Question: Does the plotted quantity increase or decrease?
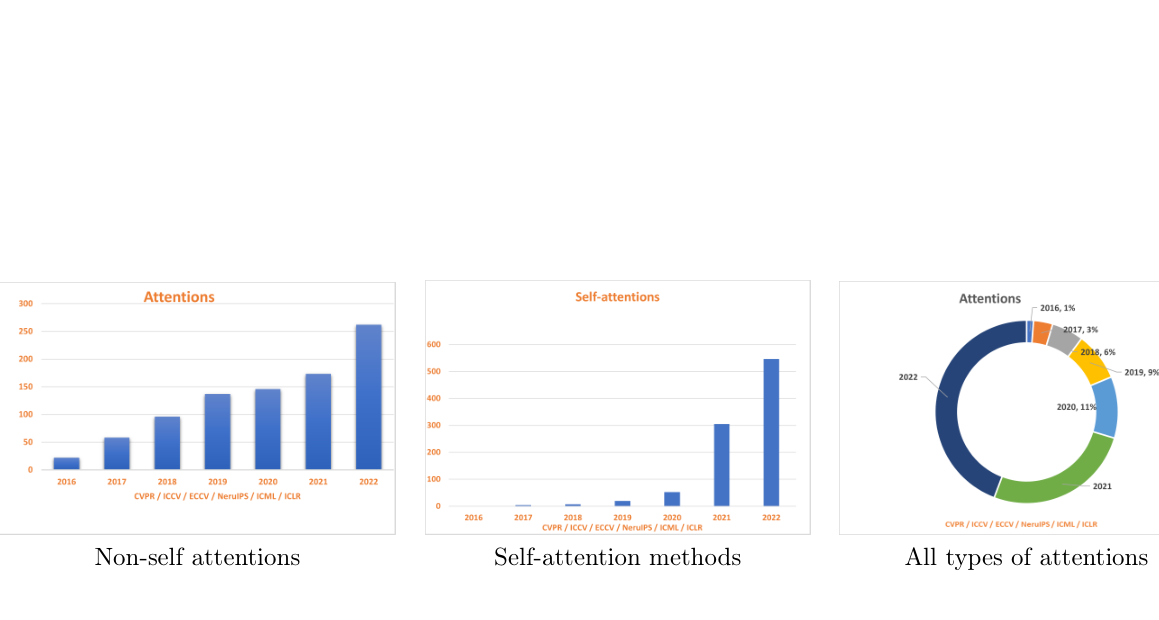
Answer: increasing